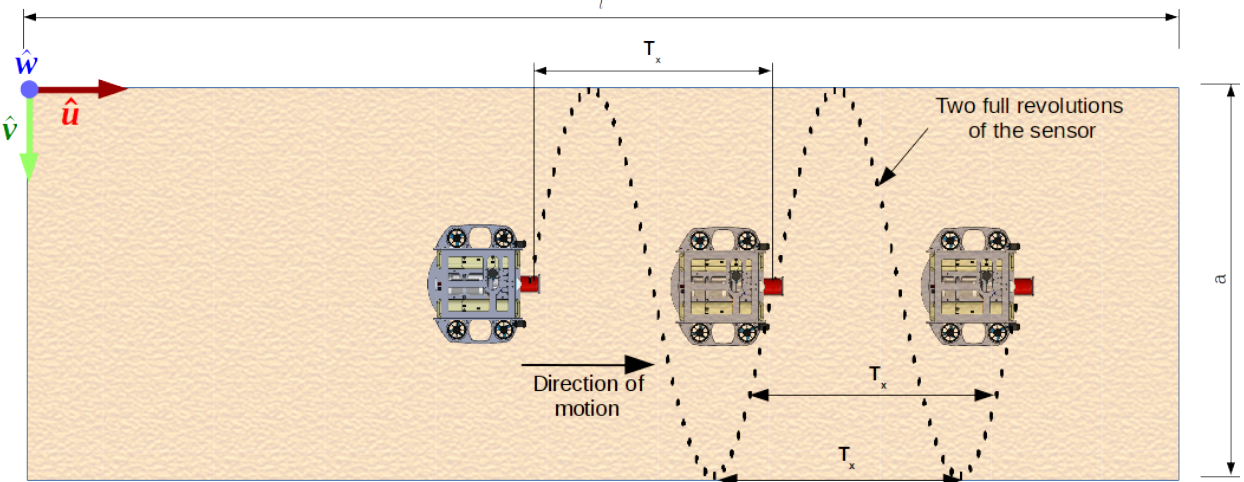
Figure 4. The impact of velocity on mapping with single point sensor when a robot moves with constant linear velocity v = ( v ,0,0 )